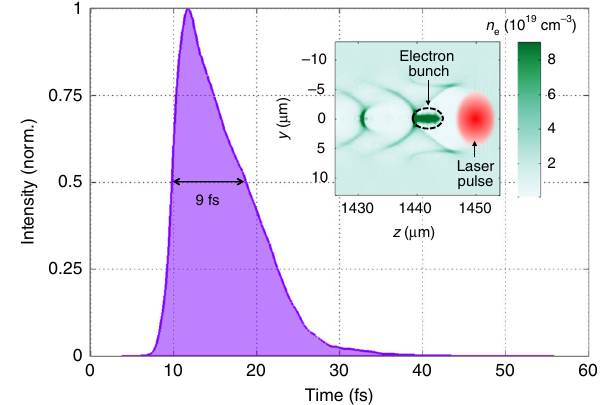
Fig. 5 Result of particle-in-cell simulations. Main curve: temporal X-ray pro fi le calculated on-axis for 930-eV photons. Inset: Two-dimensional map of the plasma density n e , showing the electron bunch accelerated in the wake of the laser pulse